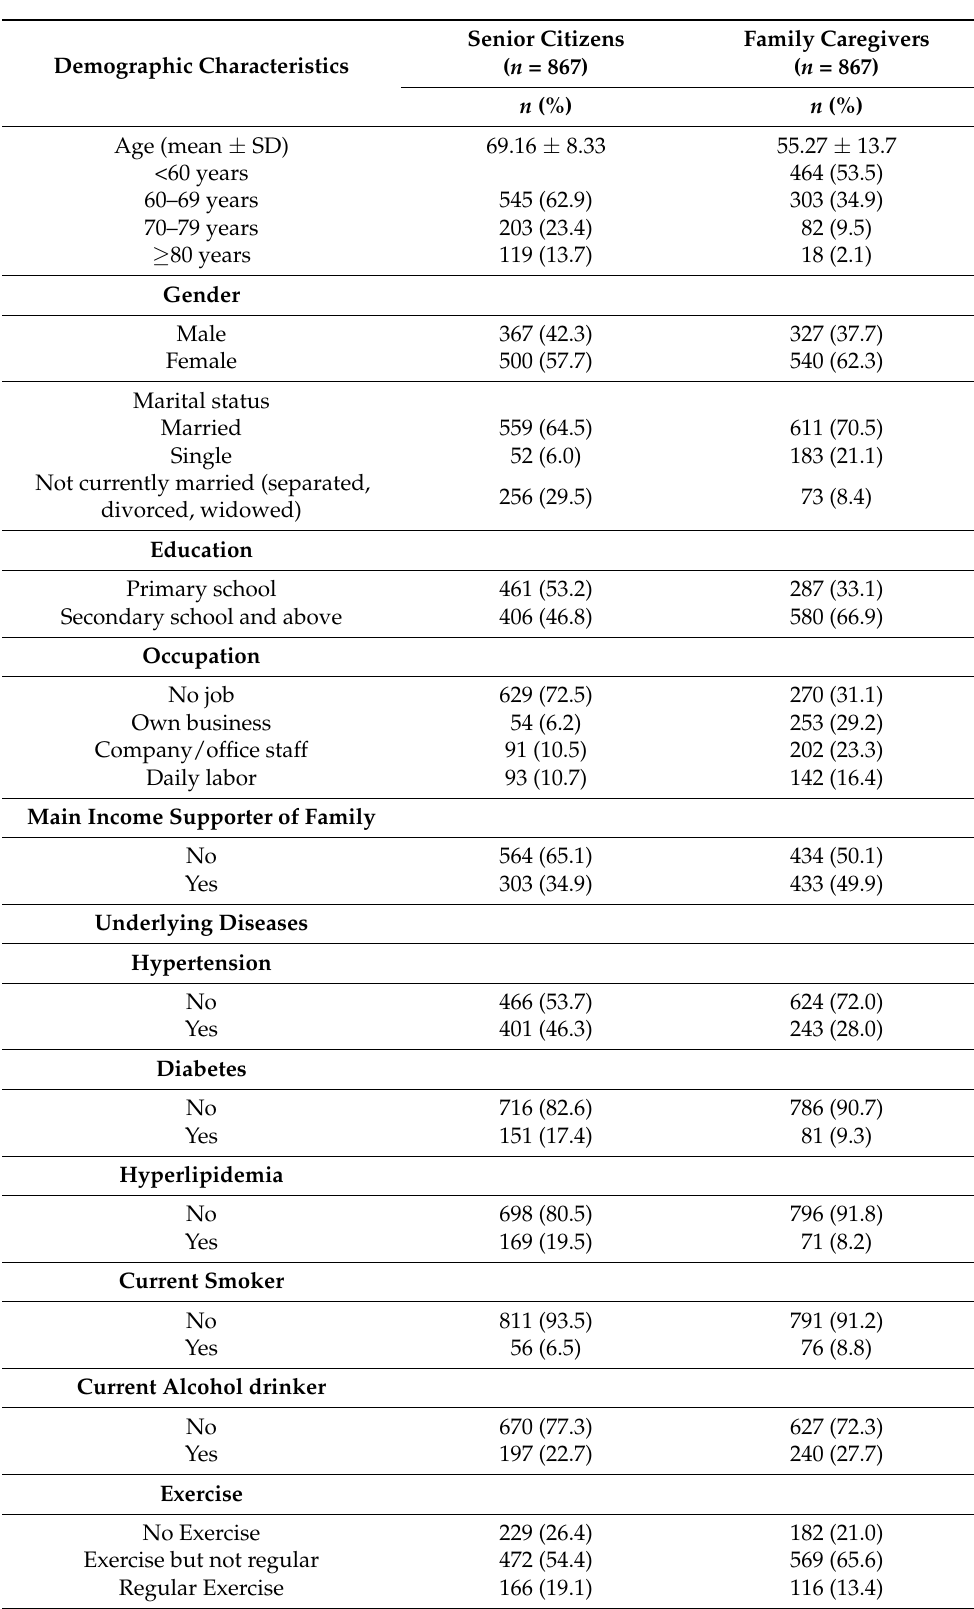
Table 1. Sociodemographic characteristics of the study participants, Maehia subdistrict, Chiang Mai, Thailand